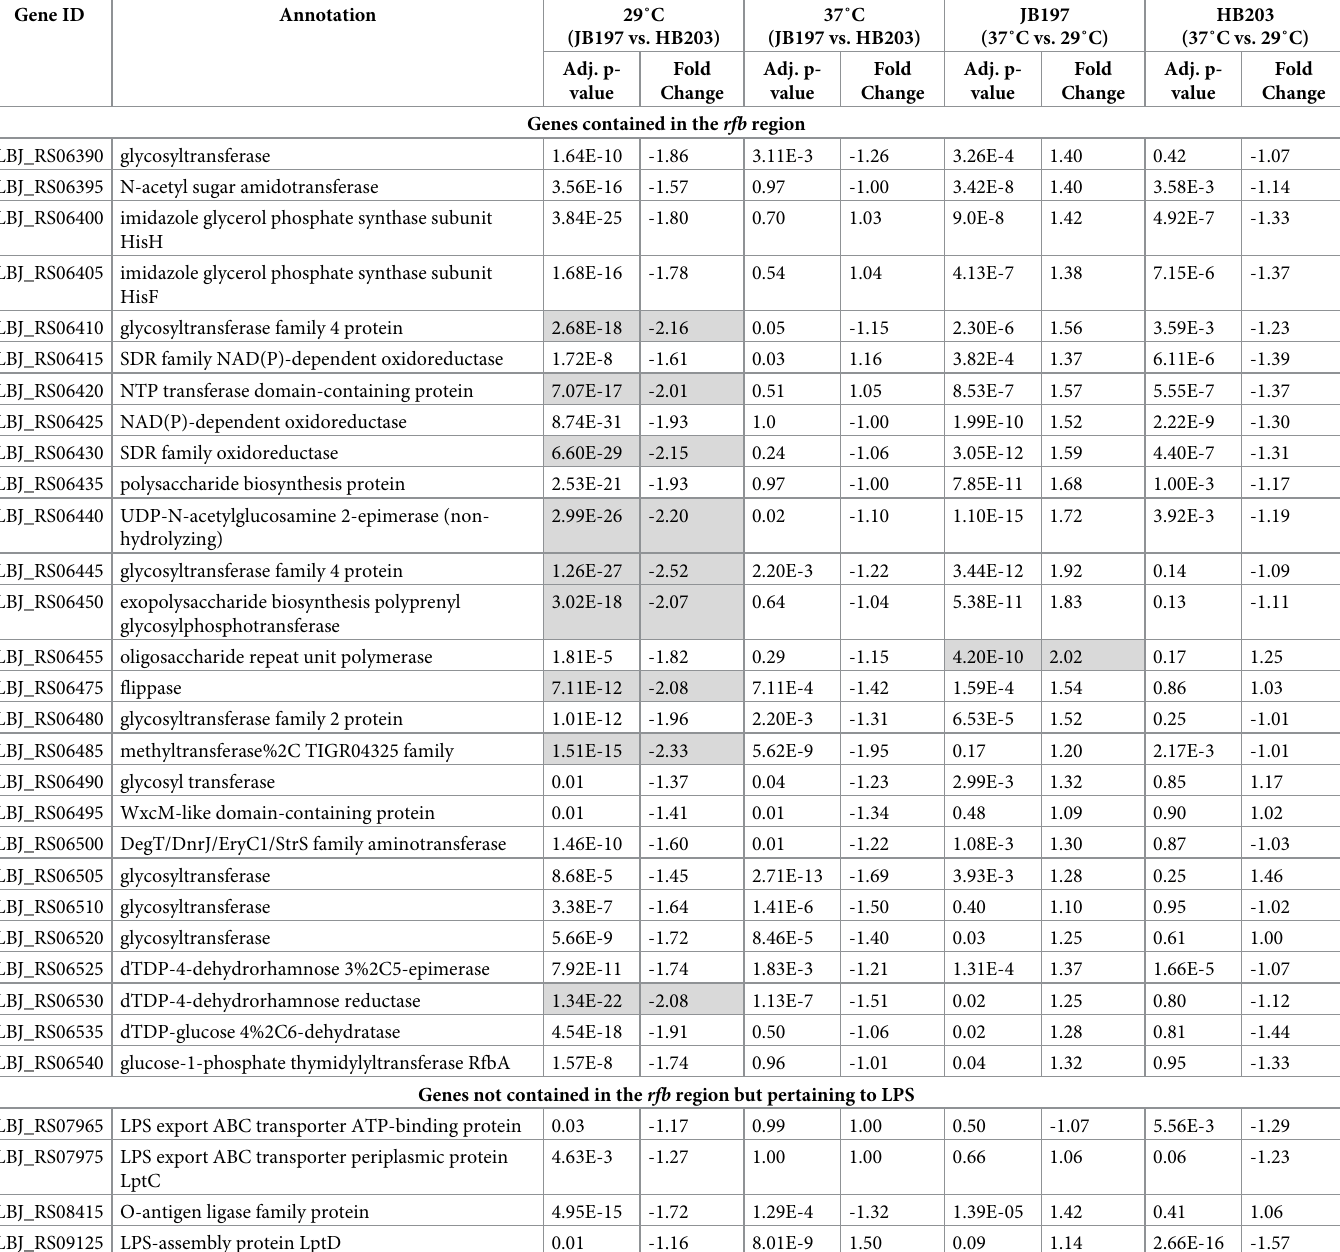
Table 6. Differential expression examination of genes within the rfb locus as well as outside the rfb locus but annotated as pertaining to LPS. Differentially expressed genes with an adjusted p-value < 0.05, and fold change minimum of two are shaded in gray. Gene